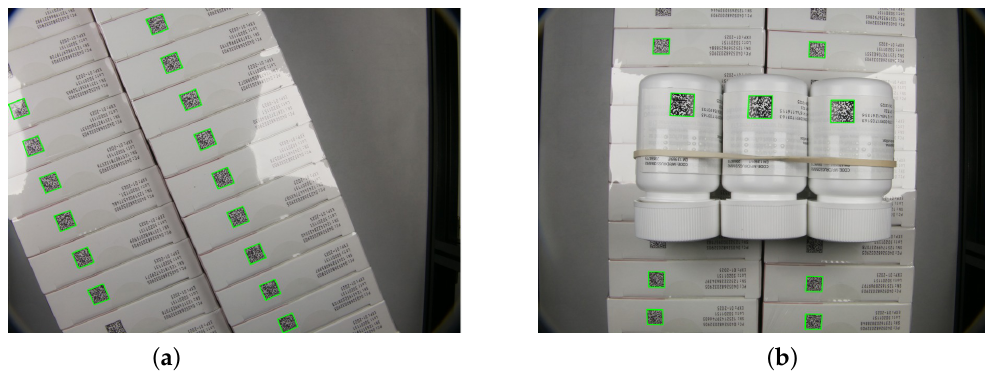
Figure 10. Medicine packages scanned: ( a ) covered by reflector plastic; and ( b ) rounded bootles.